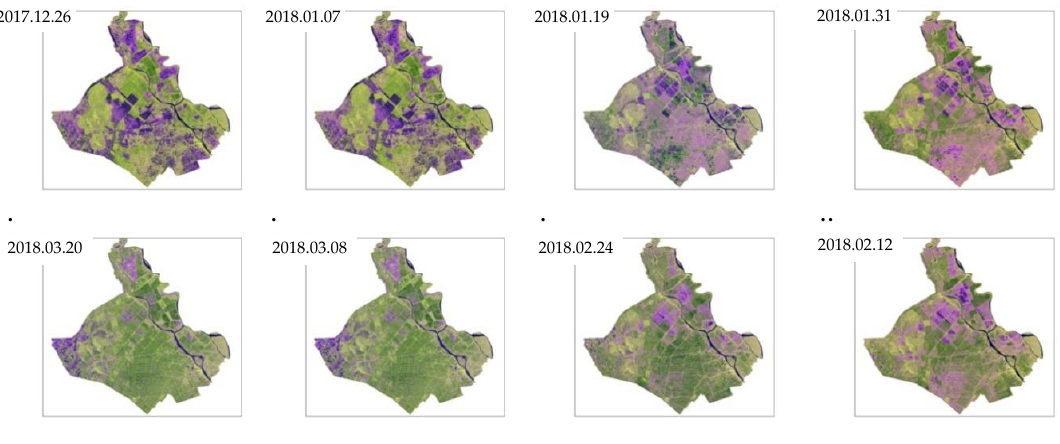
Figure A1. Multitemporal Sentinel-1A data: The display of An Giang province in composite image R:G:B by bands (VV:VH:VV / VH) (scale: 1 /